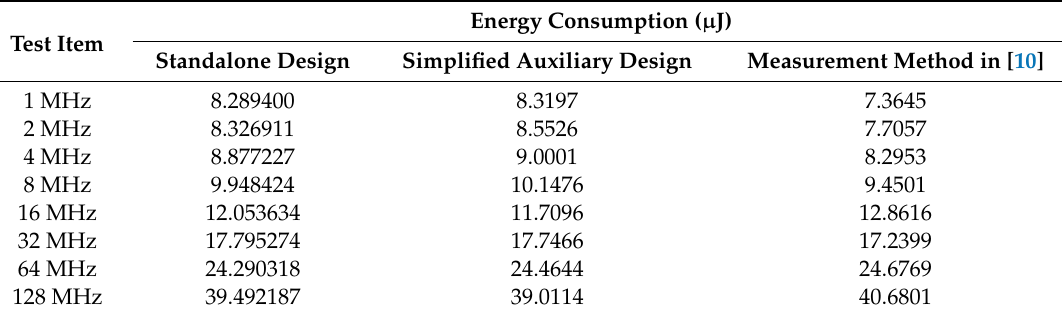
Table 2. Energy consumption of the STM32F4 processor running at different clock frequencies measured using our designs and the measurement in [10].